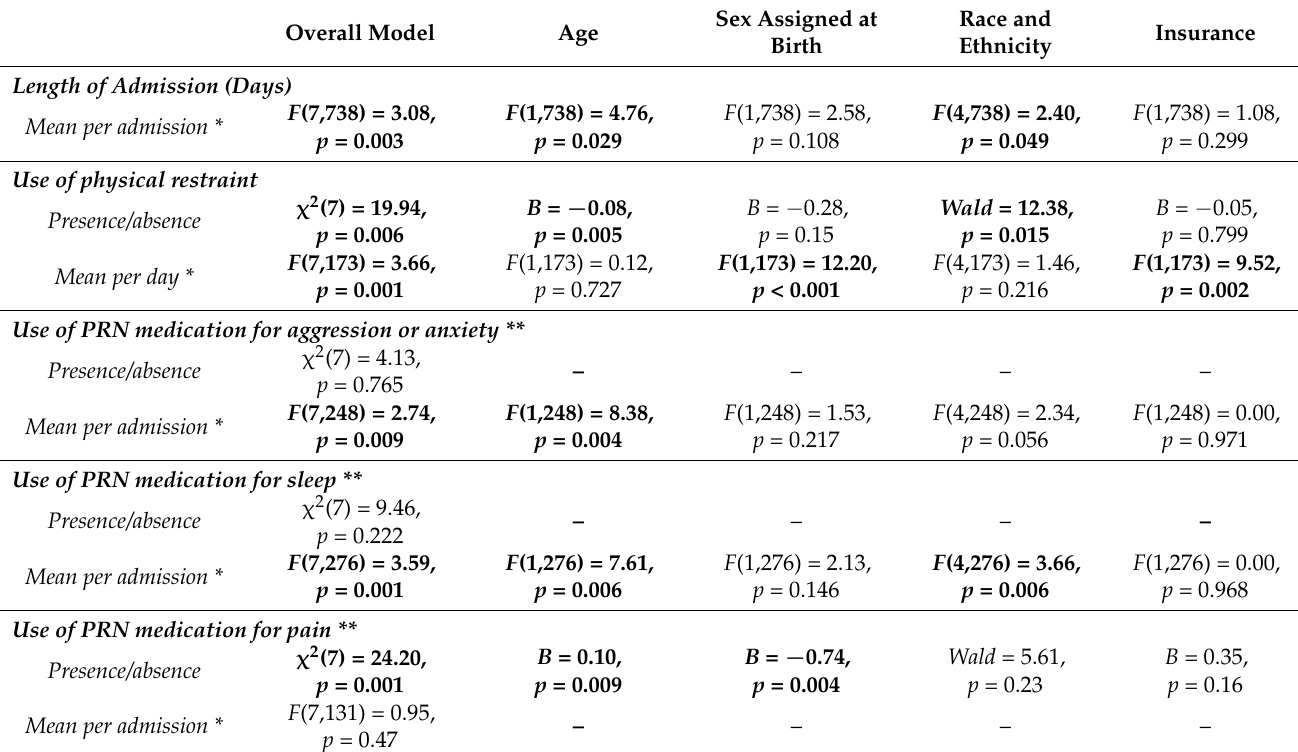
Table 4. Models evaluating demographic factors and clinical outcomes for patients with ASD/DD. Overall Model Age